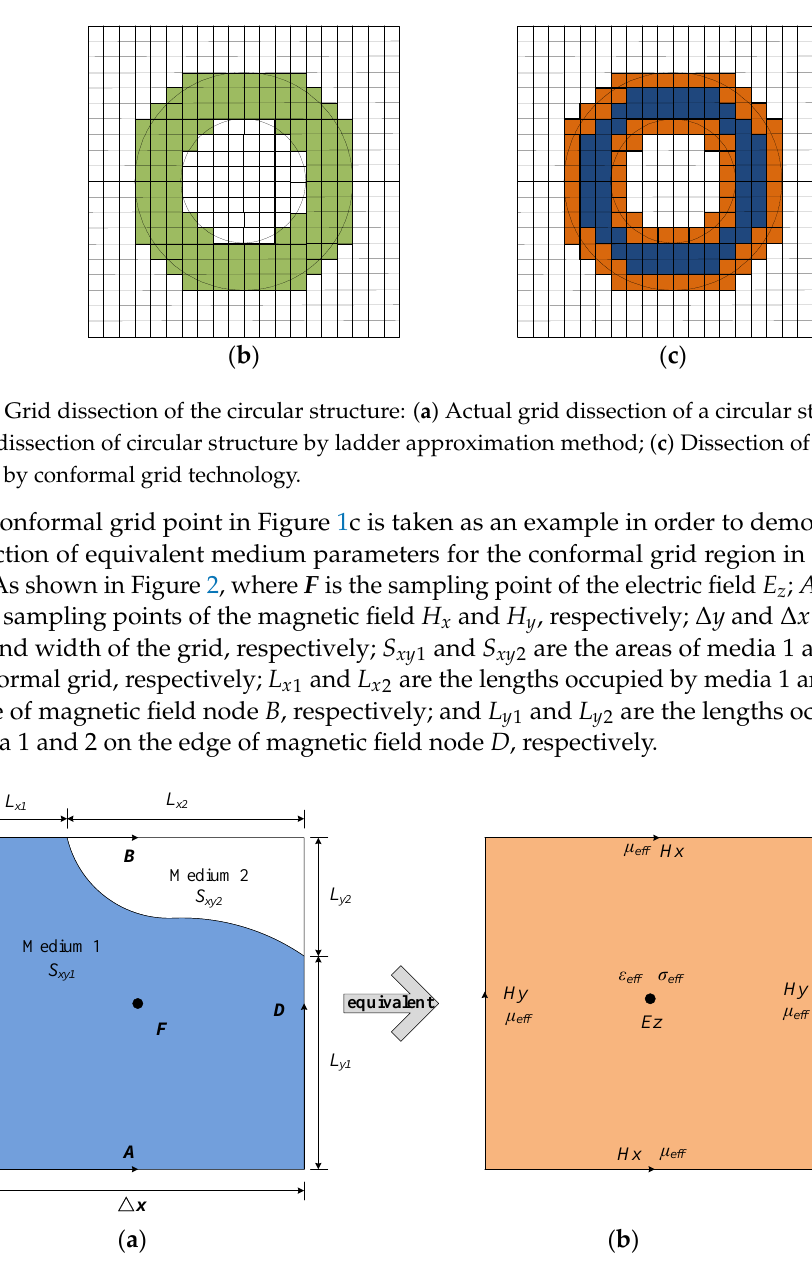
Figure 2. Equivalent schematic of the media parameters at the conformal grid points: ( a ) Actual grids; ( b ) Conformal grids.